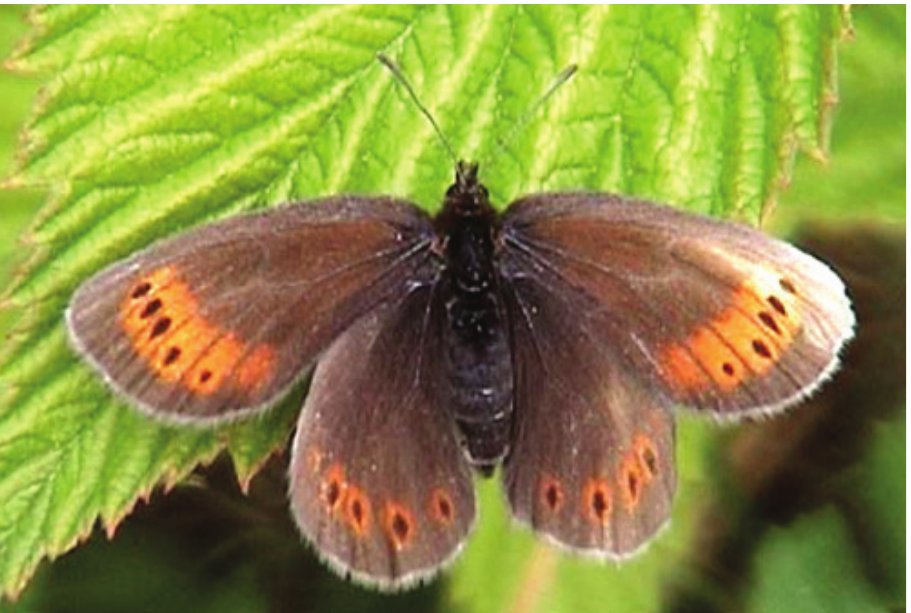
Europe: Vulnerable EU: Vulnerable Conservation Status in EU in 2007 (Article 17 assessment) Alpine region: